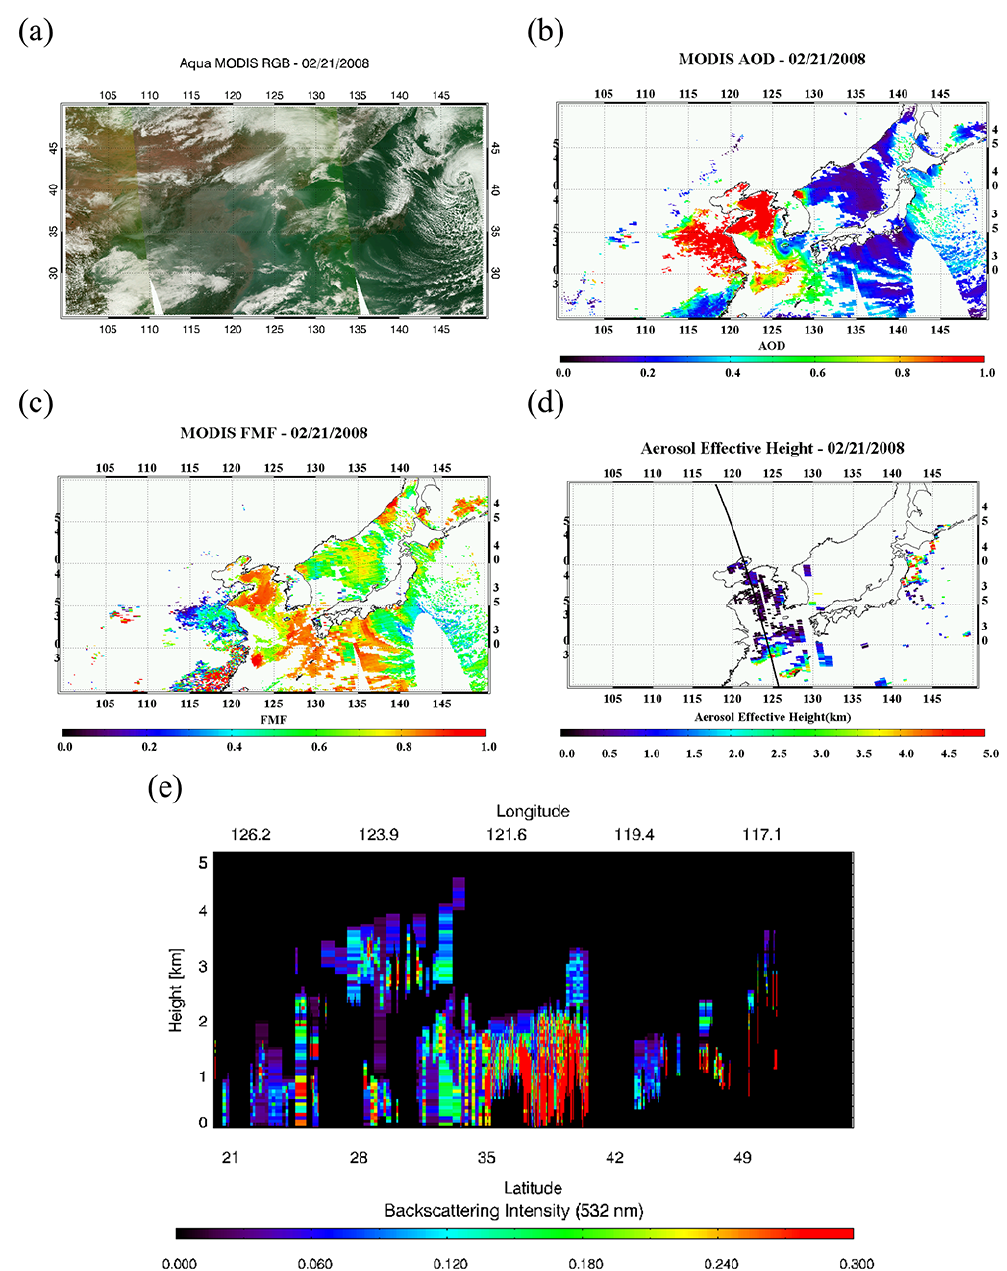
Figure 14. (a) MODIS RGB, (b) AOD, and (c) FMF; and (d) AEH distribution from OMI over East Asia; (e) backscattering intensity at 532nm from CALIOP observations over the coastal region of China on 21 February